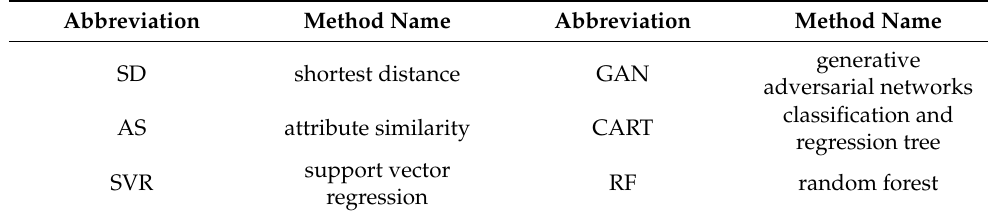
Table 3. Abbreviation of parameter regionalization methods.